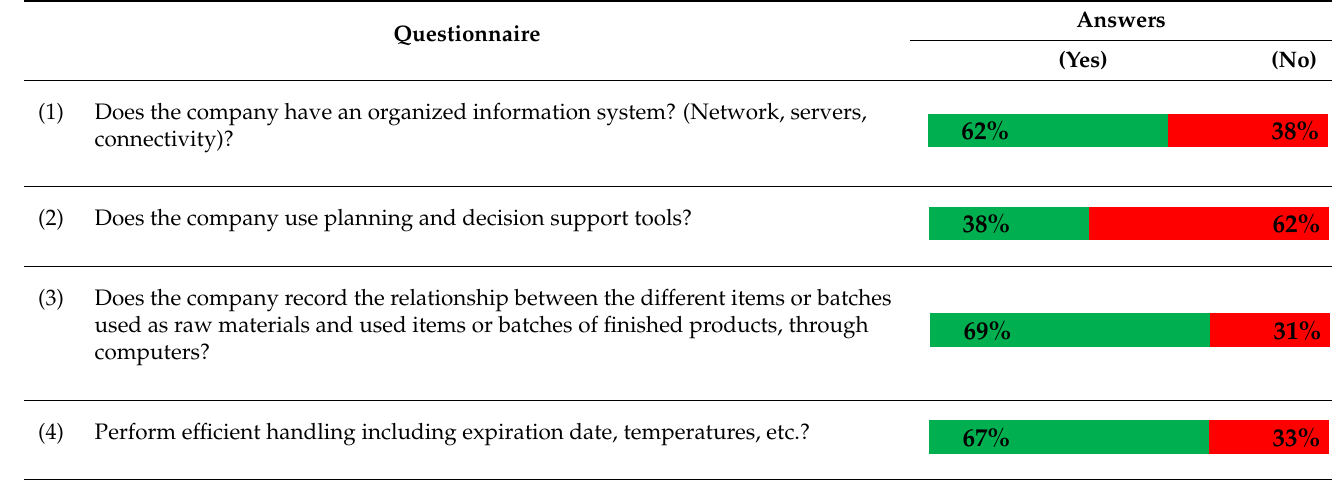
Table 5. Summary of applied survey.